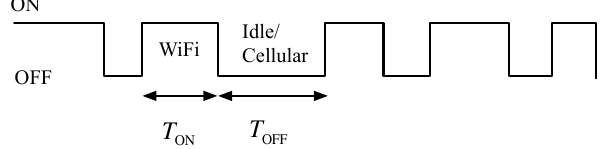
Figure 1: The WiFi network availability model